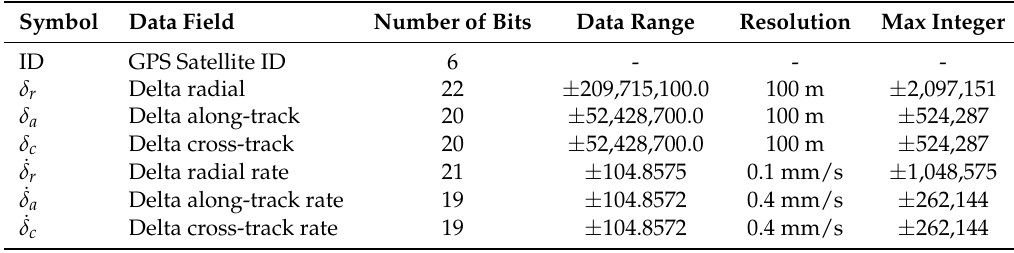
Table 3. Modified satellite specific part of RTCM 10,403.2 message